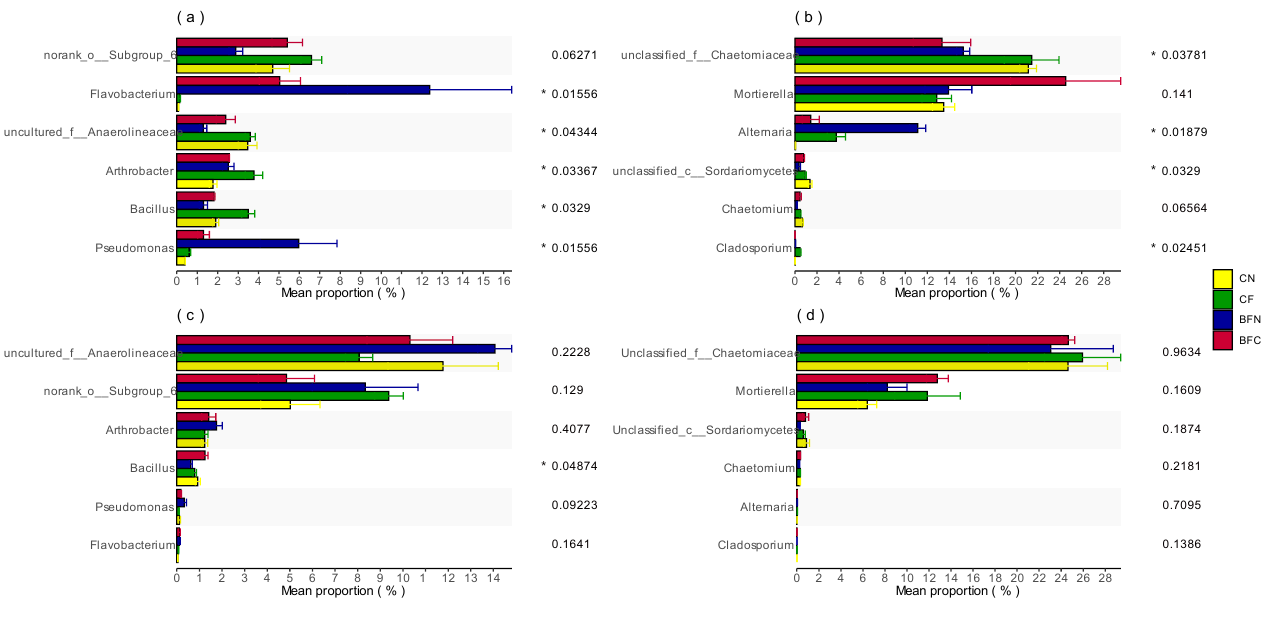
Table 2. Glucosinolate concentration (μmol·g −1 DW) in the tissues of different biofumigation mate- rials.